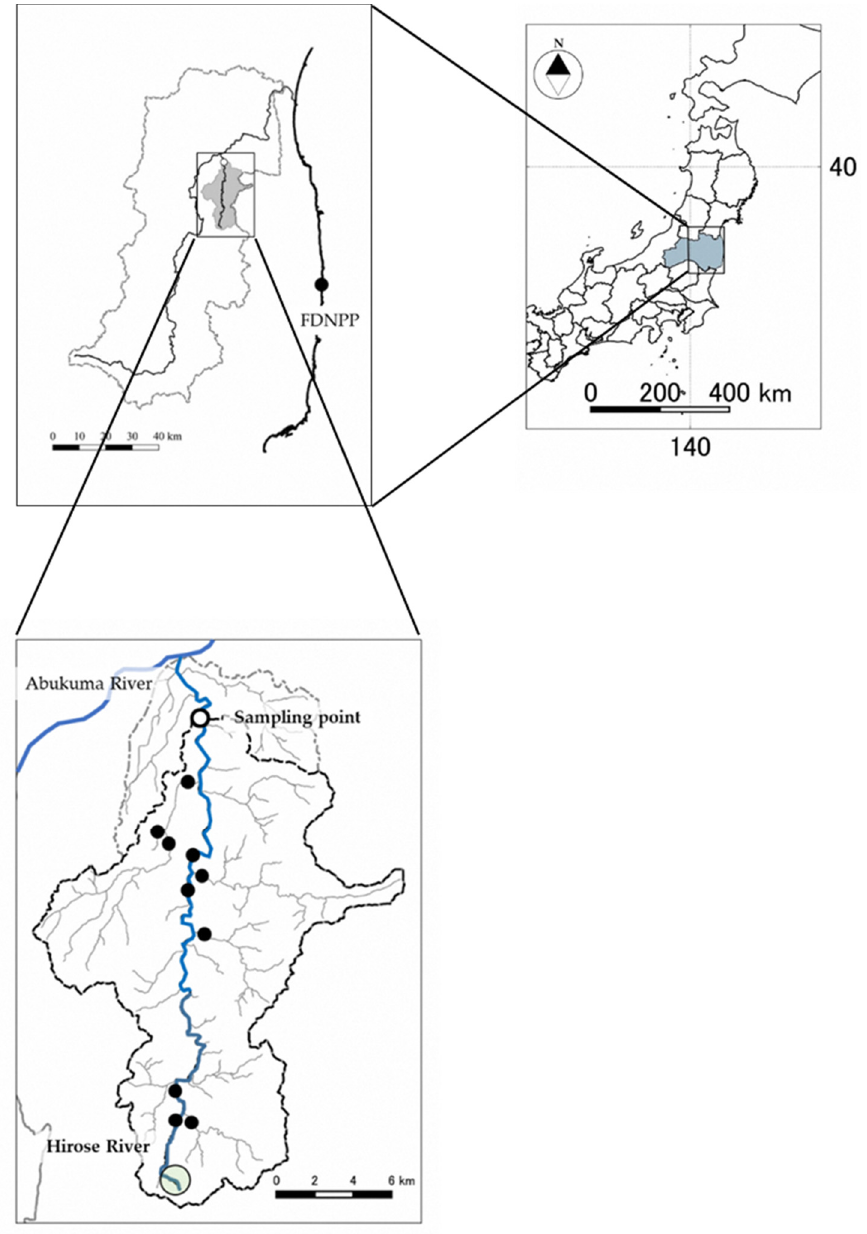
Figure 1. Location of the sampling points in the Hirose River catchment. The white circle indicates the sampling point for river water, sediments, and riverbank soil. The light-green circle indicates the sampling site for forest soil and litter, and the gray circles show the sampling sites for riverbank soil and river sediment.